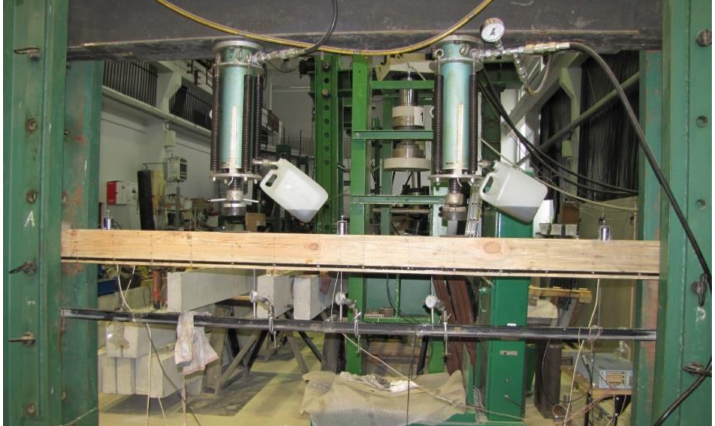
Figure 2. The experimental set-up scheme of a reinforced beam W BFRP -A2 (photo by: